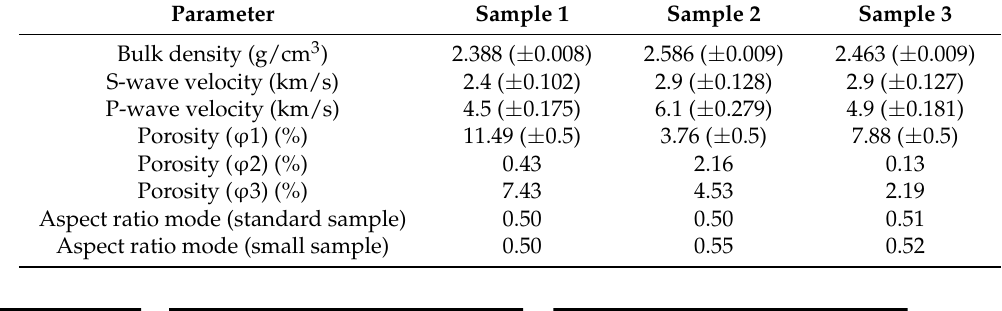
Table 1. Results of laboratory measurement.